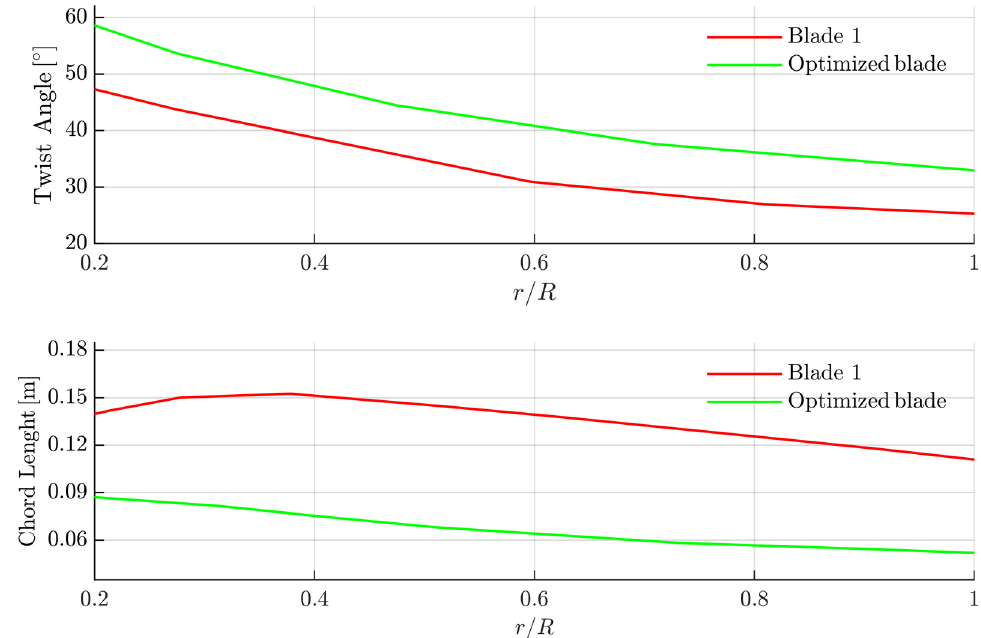
Figure 7. The geometrical parameters of the optimized and initial blades.